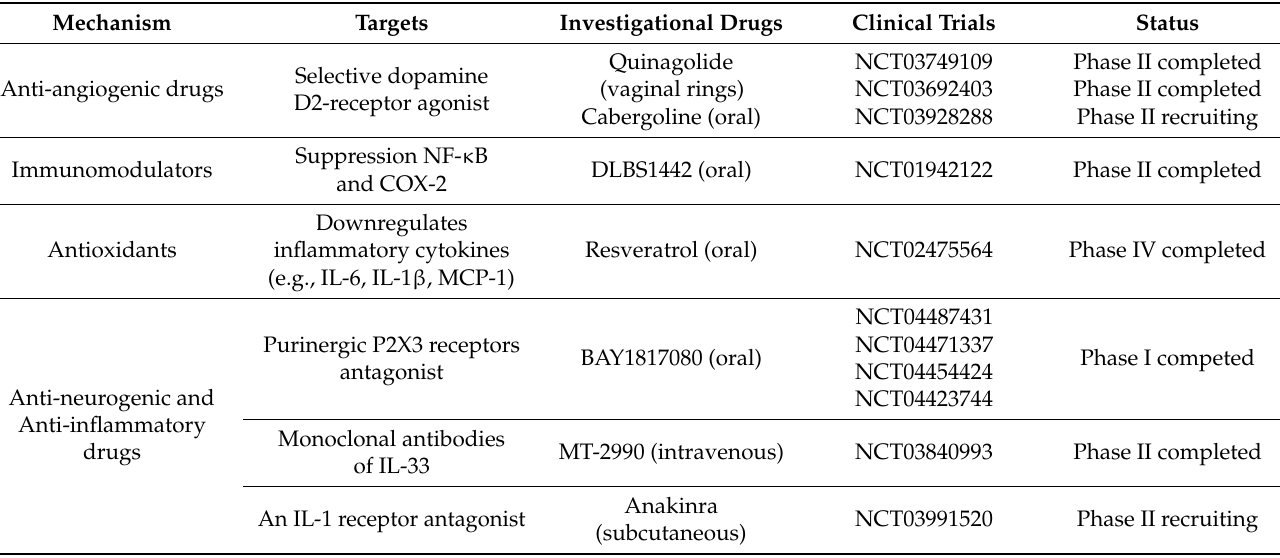
Table 1. Investigational drugs for